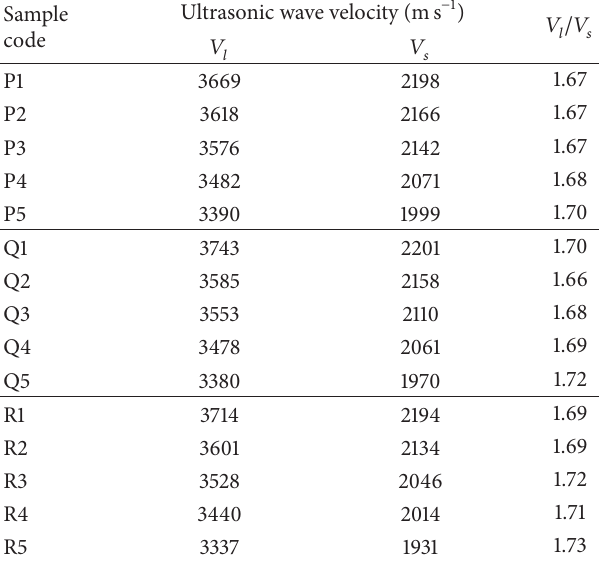
Table 2: The longitudinal and shear ultrasonic velocities and their ratio for ZOFT glass